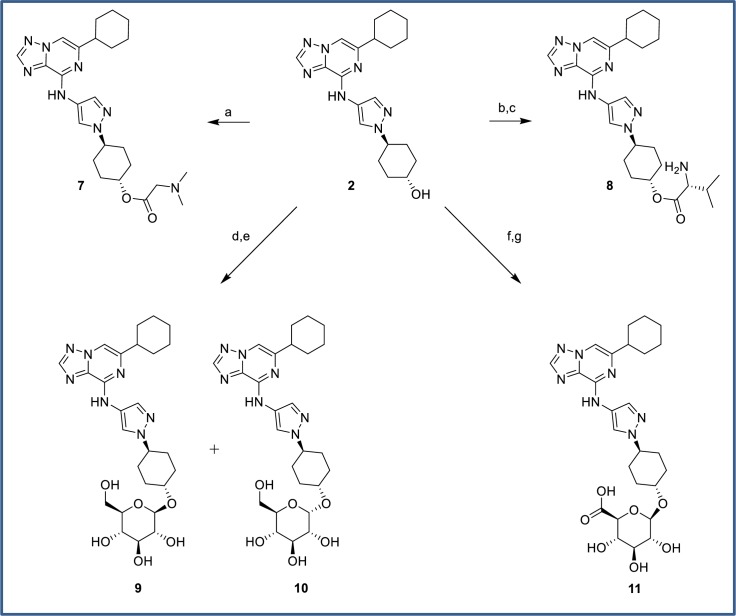
Synthesis of ester, glucoside and glucuronide prodrugs.Reagents and conditions: (a) 2-(dimethylamino)acetic acid, EDC, DMAP, DCM, rt, 92%; (b) Boc-(D)-valine, EDC, DMAP, DCM, rt, 72%; (c) TFA, DCM, 0°C to rt, 73% (d) 2,3,4,6-tetra-O-benzyl-alpha-D-glucopyranosyl trichloroacetimidate, BF3.OEt2, -78°C to rt, DCM, 95%; (e) Pd/C, H2 (10 bar), rt, 30% 9, 17% 10; (f) (2R,3R,4S,5S,6S)-2-bromo-6-(methoxycarbonyl)tetrahydro-2H-pyran-3,4,5-triyl triacetate, AgOTf, DCM, 5°C to rt, 7%; (g) LiOH, THF/H2O, 0°C, 50%.